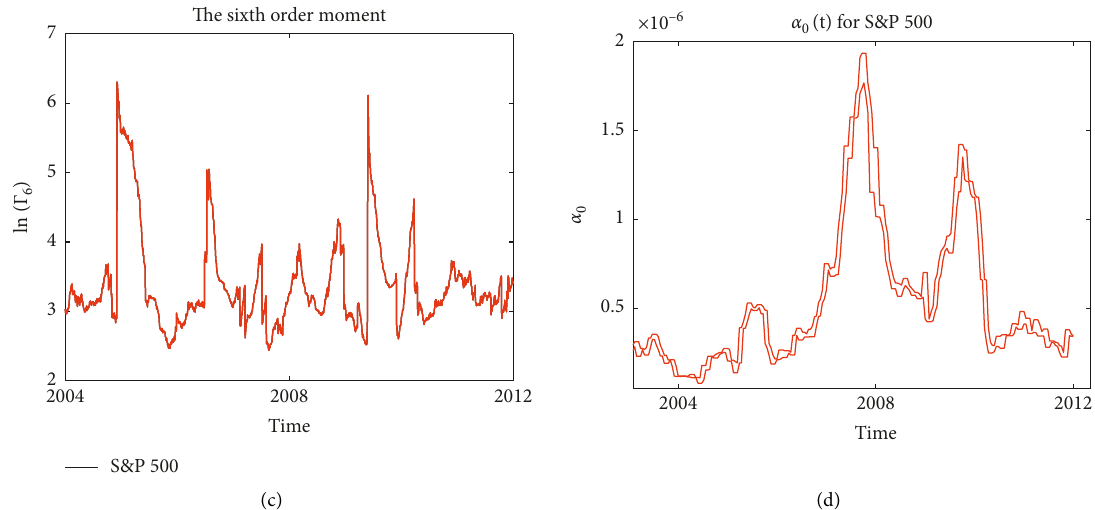
Figure 13: The evolution of the sixth-order standardised moment and GARCH parameter α throughout the COVID-19 pandemic. (a) The 0 sixth-order standardised moment evolution for the COVID-19 pandemic period. (b) The evolution for the GARCH parameter for the same period. The behaviour seen is in agreement with the banking stocks through the financial crisis of 2008. (c) The behaviour of the sixth-order standardised moment for the S&P 500 stock index through the 2008 financial crisis. We see a very noisy signal for much of the time period analysed. (d) The evolution of the GARCH parameter, α . We show the analysis for the parameter for the period 2004 to 2012. The parameter 0 evolution for the S&P 500 shows a similar dynamic to the pandemic period. However, the peak is an order of magnitude lower than seen in the COVID-19 pandemic period.